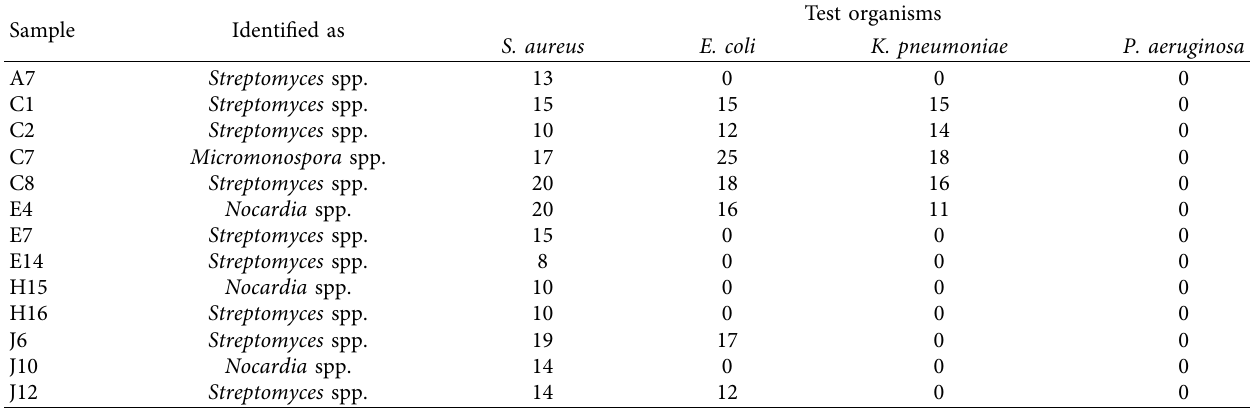
Table 4: Zone of inhibition of active isolates in secondary